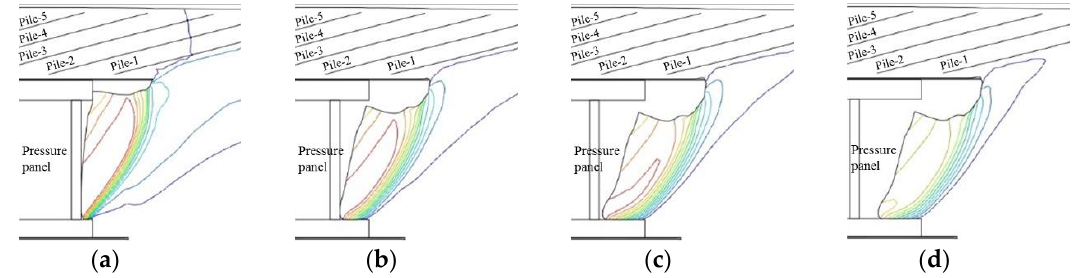
Figure 13. Variation in stress acting on piles according to time during the fifth cycle at cover depth of 1.5 m.